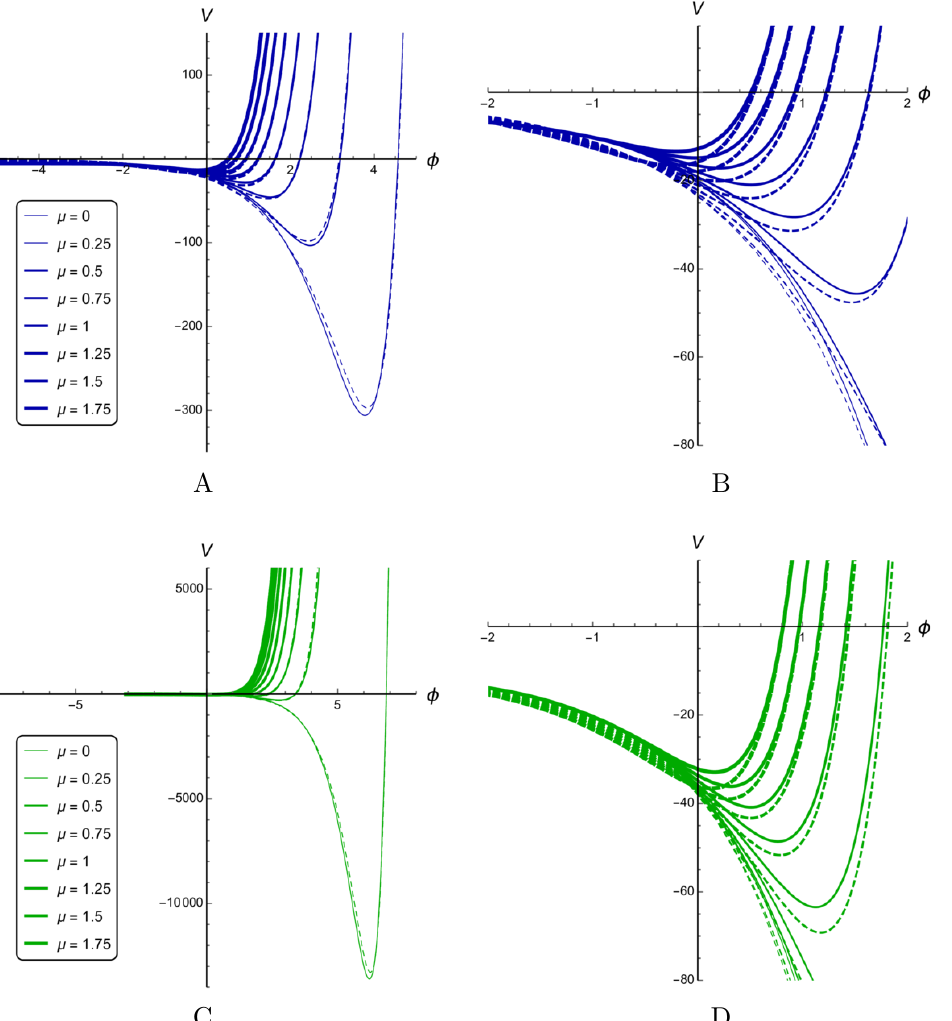
Figure 6 . Scalar (cid:12)eld potential V ( (cid:30) ) (solid lines) and its approximation (dashed lines) as a sum of two exponents and a constant for z h = 1, c = (cid:0) 1 and di(cid:11)erent (cid:22) in anisotropic, (cid:23) = 4 : 5, (A) and isotropic (C) cases. The right plots (B) and (D) are zoom of the corresponding left